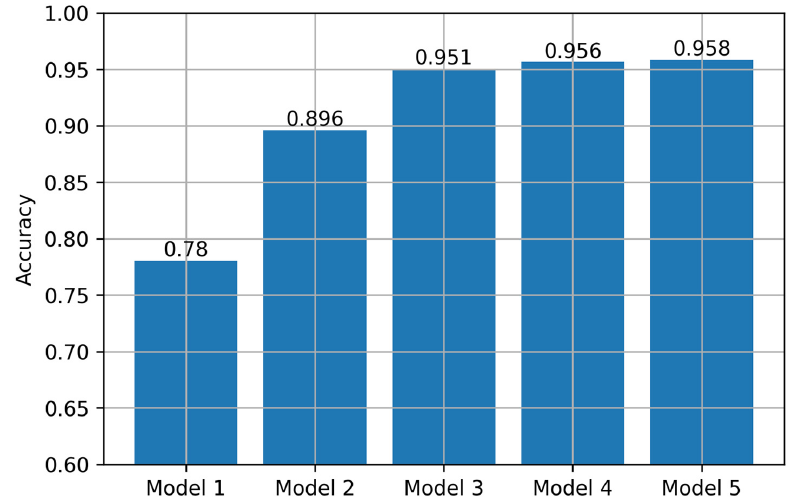
Figure 19. Accuracy of Xception models with data augmentation.